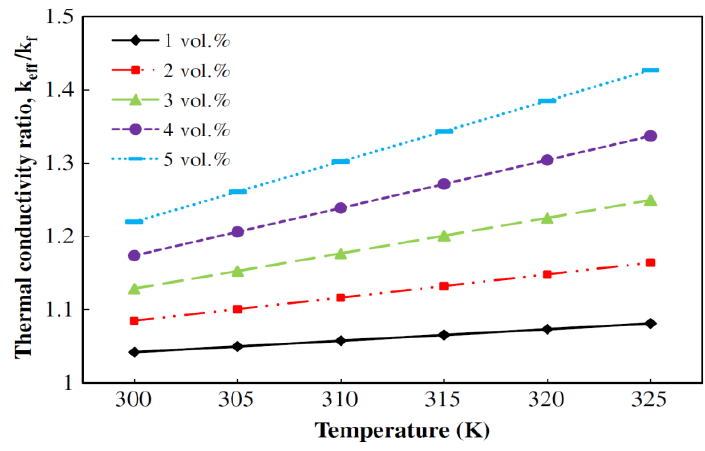
Figure 3. Thermal conductivity ratio as a function of temperature [23].